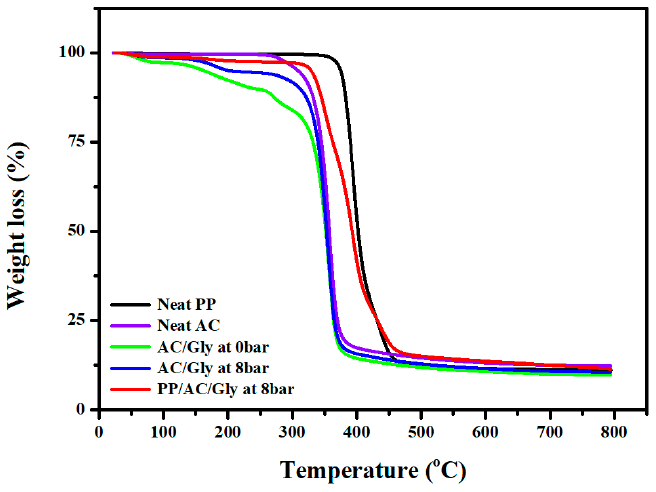
Figure 4. TGA data of neat PP, AC film, AC/Gly, and PP/AC/Gly separators.